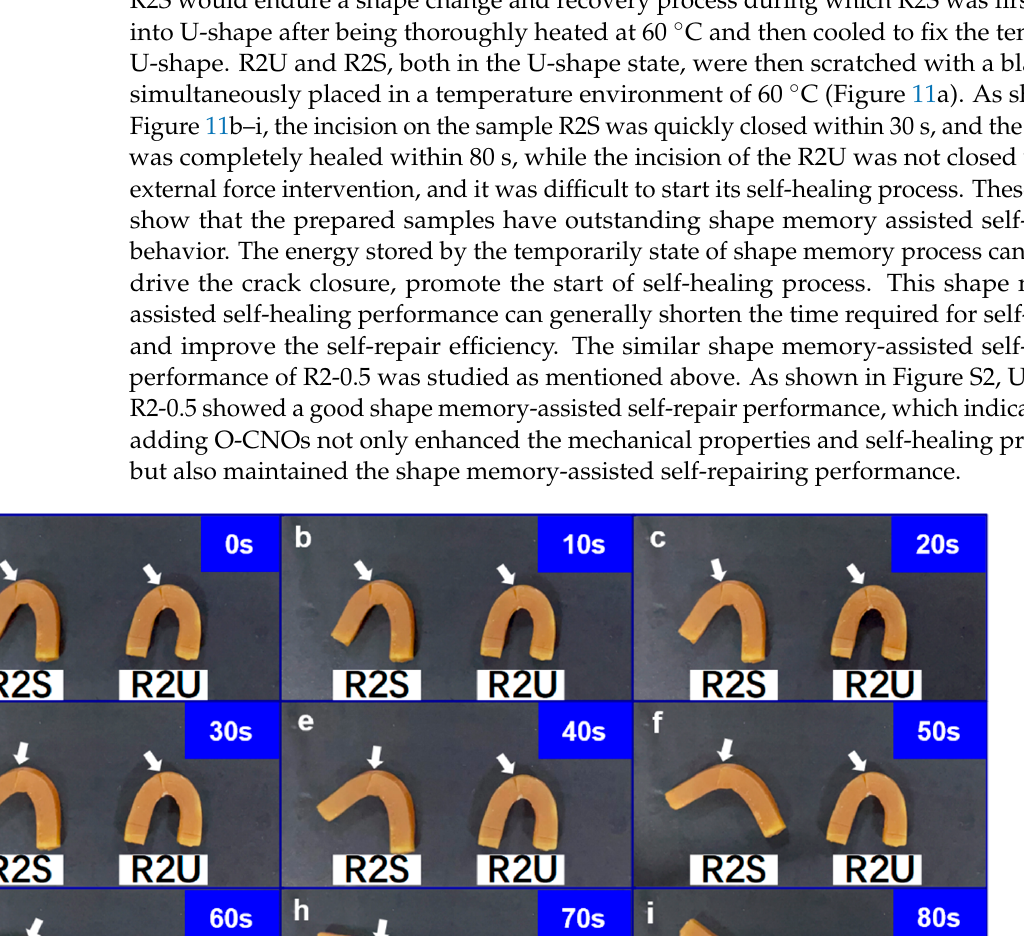
Figure 11. Snapshots of the shape memory assisted self-healing process. ( a ) 0s, ( b )10s, ( c ) 20s, ( d ) 30s, ( e ) 40s, ( f ) 50s, ( g ) 60s, ( h ) 70s, ( i ) 80s.